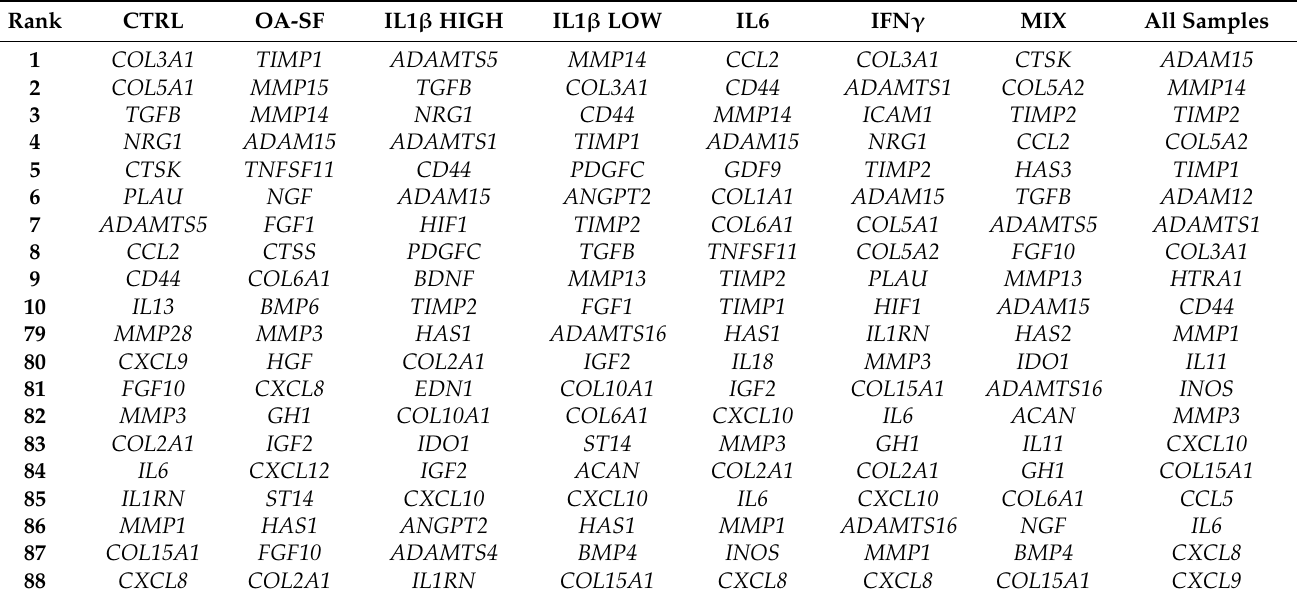
Table 2. Top 10 and bottom 10 ranking positions in the stability between donors for the expression of genes in each experimental condition.